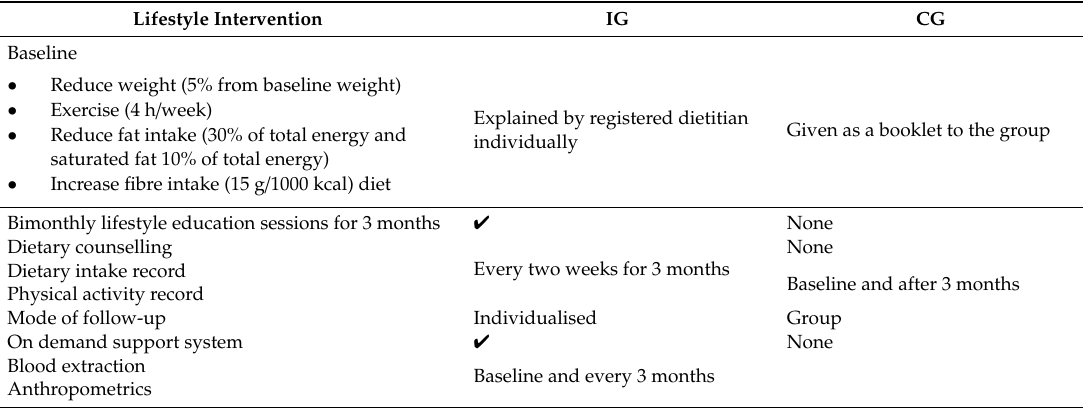
Table 1. Interventions given to